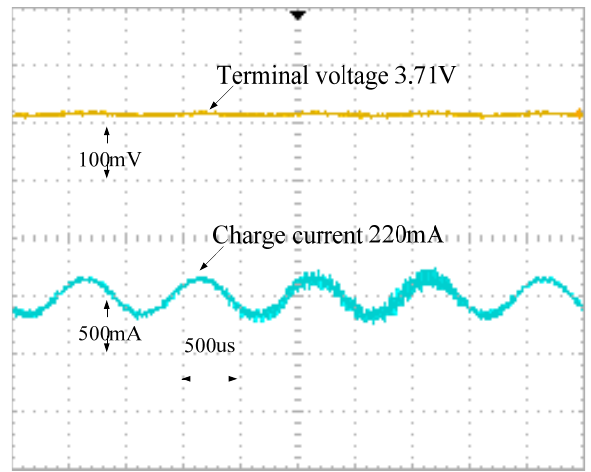
Figure 18. The measured charge current and terminal voltage waveforms at an SOC of 50%.